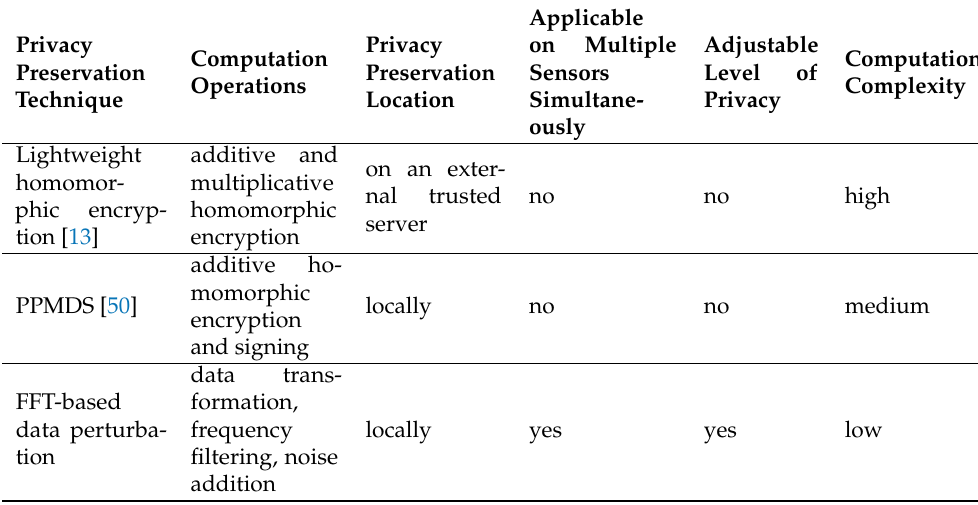
Table 1. Comparison to the closest related privacy-preserving anomaly detection techniques applica- ble to automotive